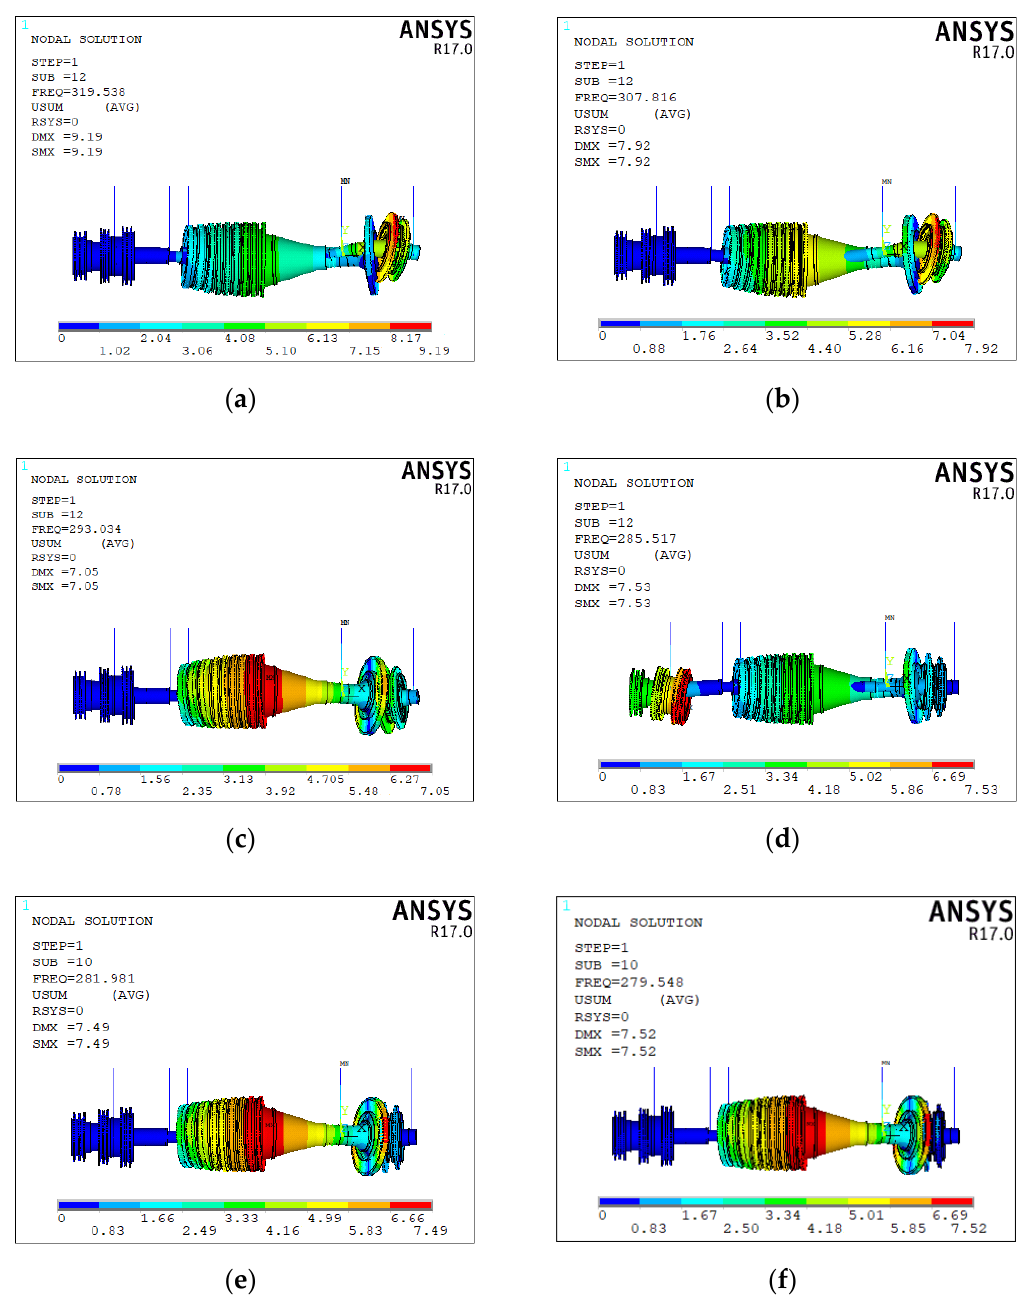
Figure 18. The 5th order modal for contrast in different front deflection angle non-concentricity: ( a ) θ = 0.05°; ( b ) θ = 0.1°; ( c ) θ = 0.15°; ( d ) θ = 0.2°; ( e ) θ = 0.25°; ( f ) θ = 0.3°.